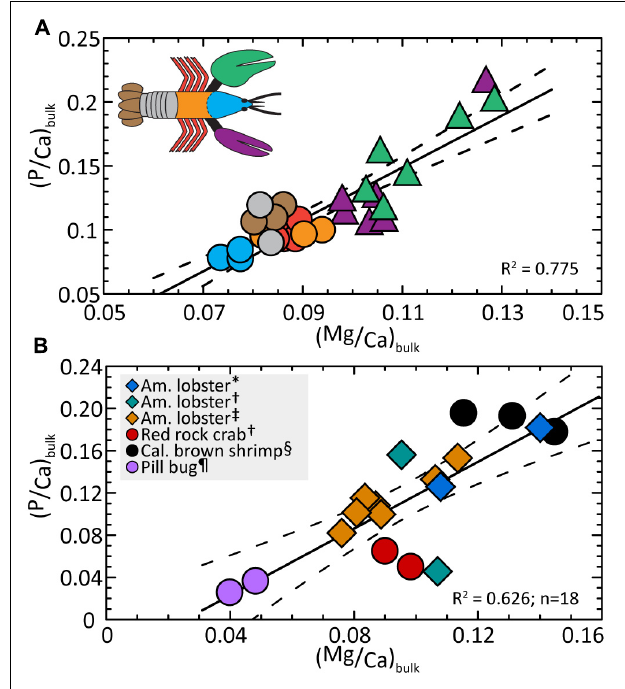
FIGURE 6 | (A) Ratios of P/Ca and Mg/Ca are covariant in the lobster bulk exoskeleton. Compositions indicate a linear trend that includes all body parts and also resolves the cephalon (head), main body, and claw compositions into distinctive ranges. Linear regression (Eq. 5) finds P/Mg is conserved at 1.27 ± 0.30 across all body parts. (B) The available exoskeleton data for other Malacostraca animals ( Supplementary Table S2 ) are compared with measurements from this study (one averaged data point per body part) and show a similar interspecies correlation. Dashed lines correspond to the 2 σ standard error (95% confidence interval) about the regression (solid line). Detailed statistics are given in Supplementary Table S3 . ∗ Clarke and Wheeler (1922), † Boßelmann et al. (2007), ‡ this study; § Huner et al. (1979), ¶ Becker et al.